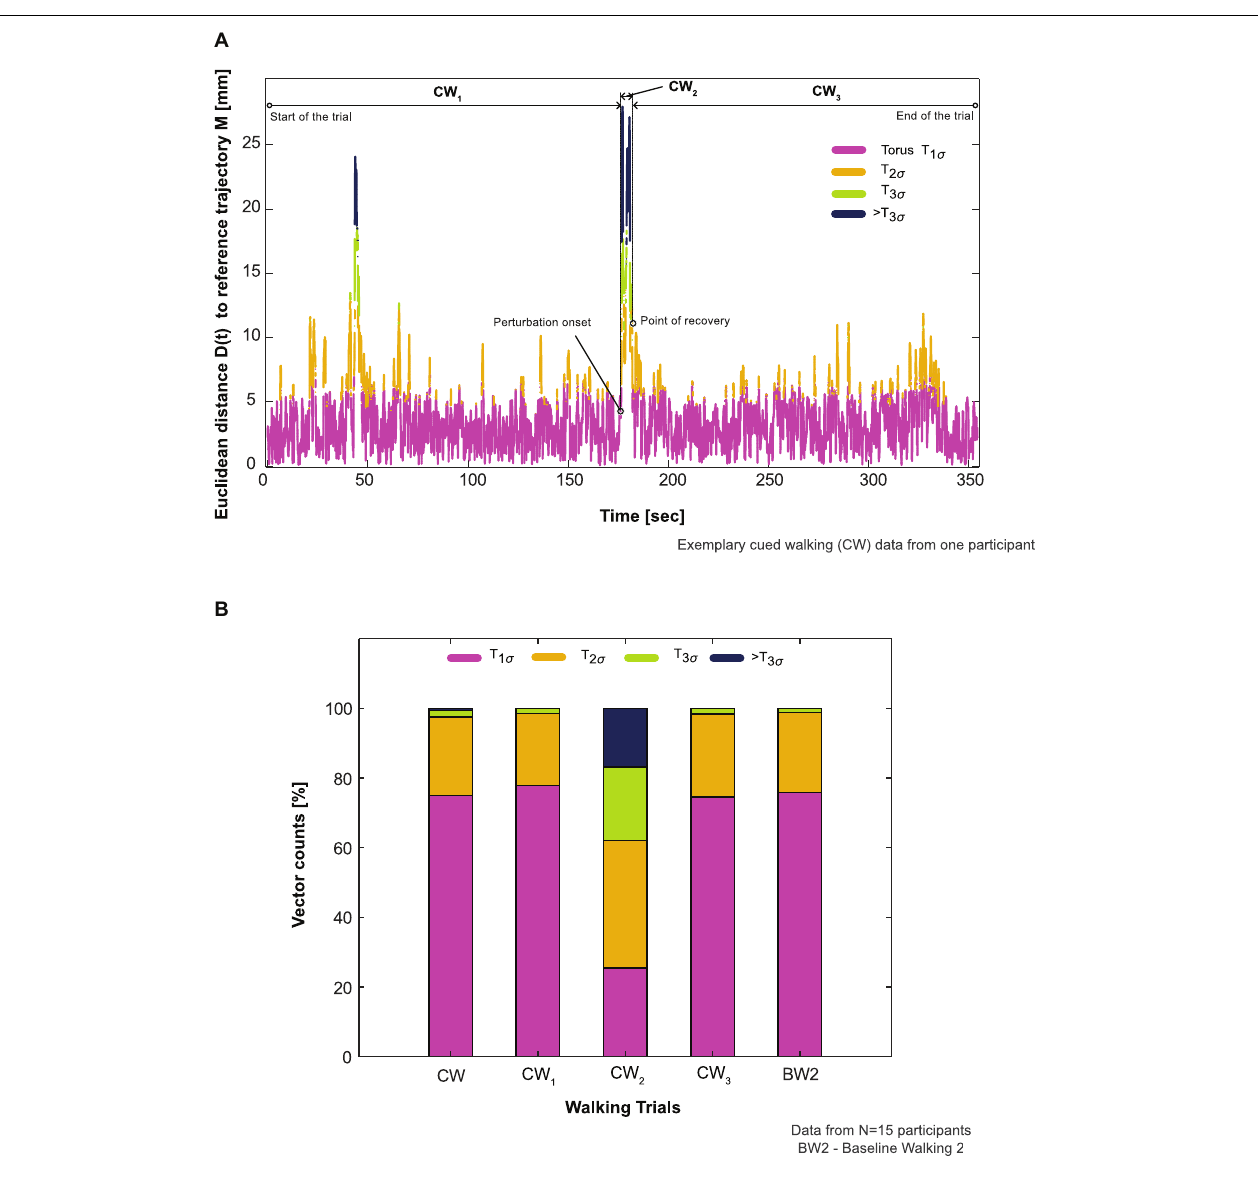
FIGURE 4 | Participants’ aggregate response to the auditory perturbation. (A) Comparison of an exemplary participant’s aggregate response in the cued walking (CW) trial during the period of recovery (CW 2 , onset of auditory perturbation until center of mass recovery) to before (CW 1 , start of the walking trial until the onset of the perturbation) and after this period (CW 3 , point of center of mass recovery until the end of the trial). The proportion of vector counts within the steady state boundaries (Torus T 1 σ , T 2 σ , T 3 σ ) and outside ( > T 3 σ ) determined the aggregate response. (B) Comparison of participants’ aggregate response between the different phases of CW, CW itself, and baseline walking 2 (BW2) in all the participants who showed deviation from steady state patterns in response to the auditory perturbation ( N =